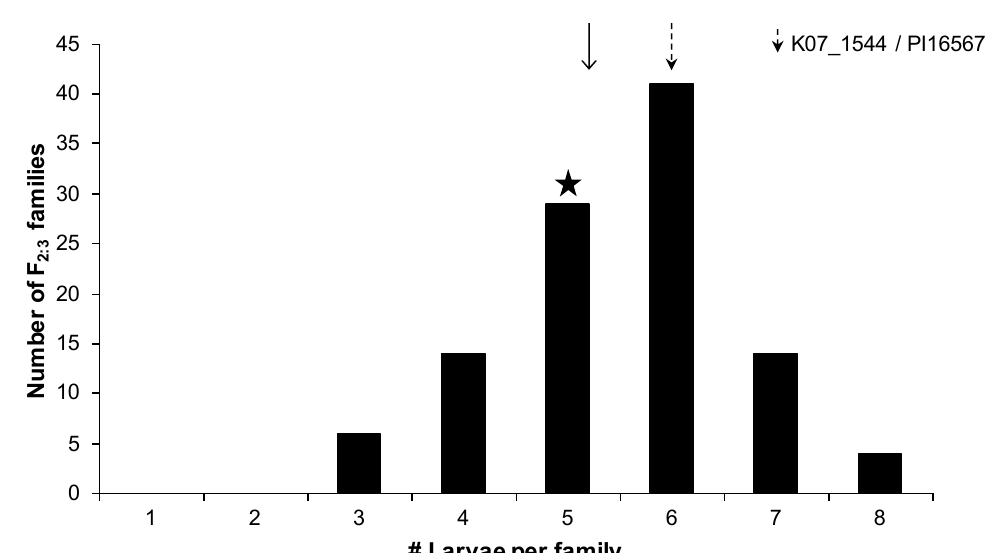
Figure 7. Frequency distribution of number of larvae per plant in plants from 108 F 2:3 families from the cross K07- 1544/PI165673 at 21 d post infestation with Dectes texanus in 2012. Arrows and star indicate parent and F 2:3 population mean, respectively. Table 3. Chi-square tests for goodness of fit of F 2:3 families K07-1544/PI165673 OL antibiosis ratio. Observed Expected Phenotypic Ratios Frequencies